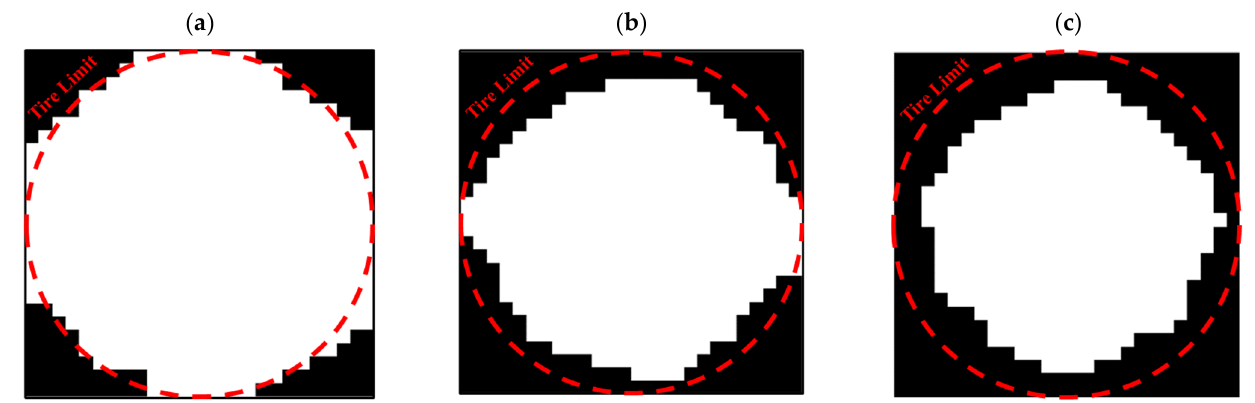
Figure 15. The optimized tire with one type of material: ( a ) 20%, ( b ) 40%, and ( c ) 60% of the weight constraint.